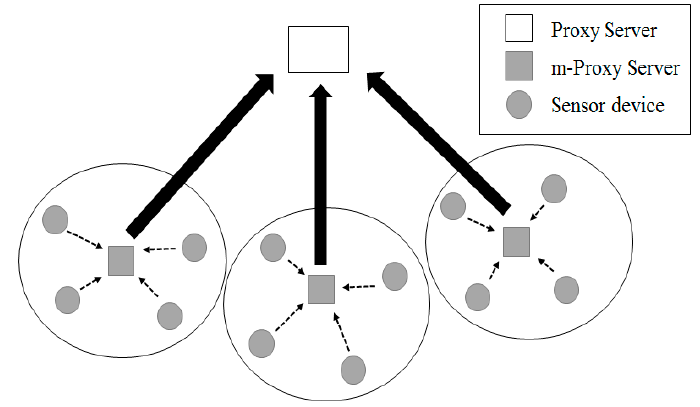
Figure 5. Clustering of Sensor Networks in an IoT environment.